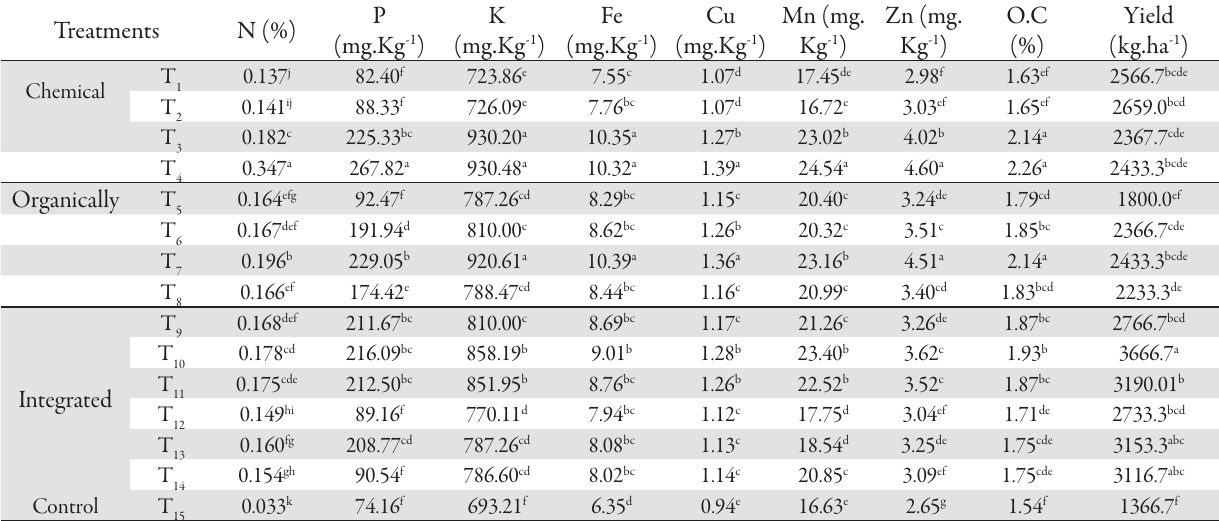
Tab. 5. Comparison of means on micro and macro elements, organic carbon and seed yield affected by different nutrition